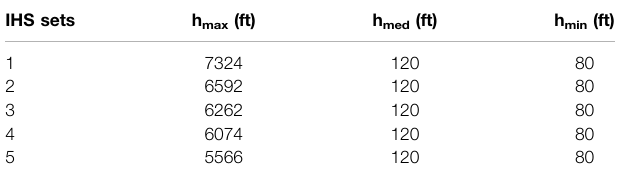
TABLE 1 | Variogram inputs for